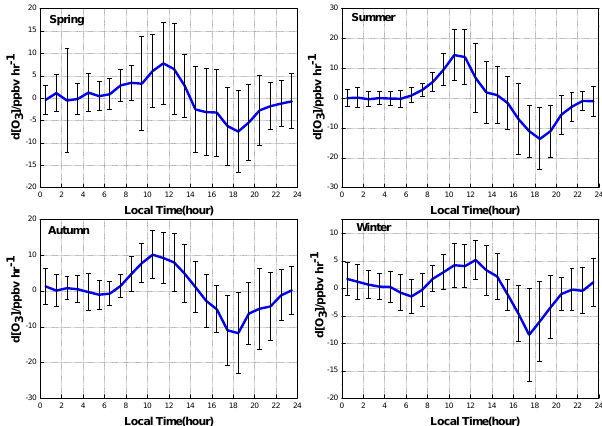
Figure 5. Average diurnal trends in ozone for each season during June 2011 to May 2012 at GPACS. The blue lines represent hourly mean values and the black bars represent the standard